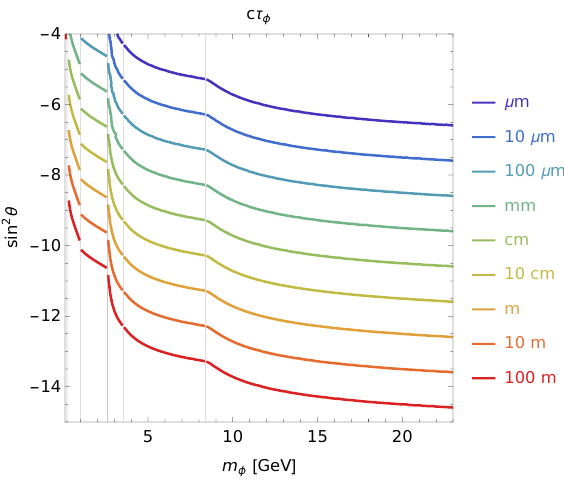
Figure 2 . Decay length of the singlet [19] depending on its mass m φ and mixing angle sin θ